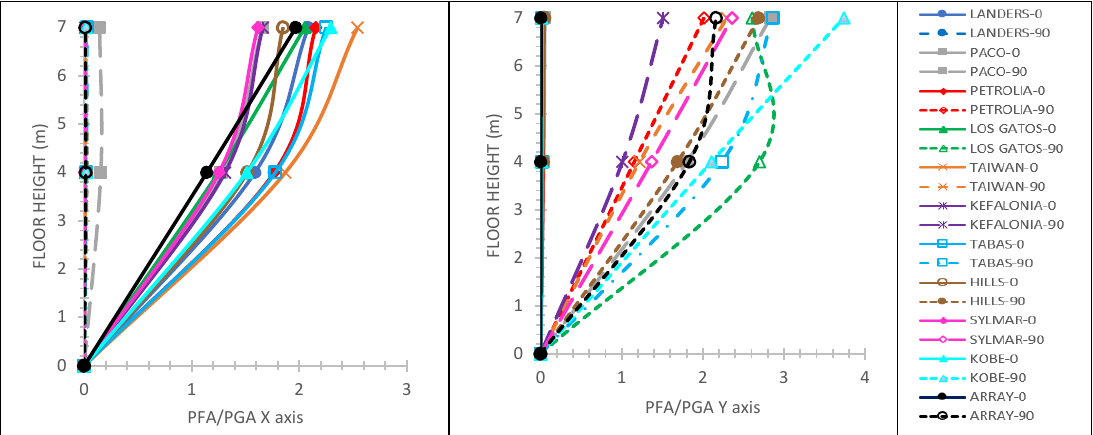
Figure 5. PFA/PGA along X ( left ) and Y ( right ) horizontal directions of the two-story mixed building, considering the fixed connection of the steel structure to the r/c one.